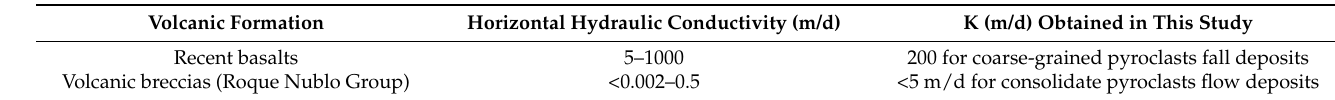
Table 1. Hydraulic conductivity values obtained by previous studies [49], and maximum and minimum K values measured by Ksat equipment for this study in volcanic formations of the